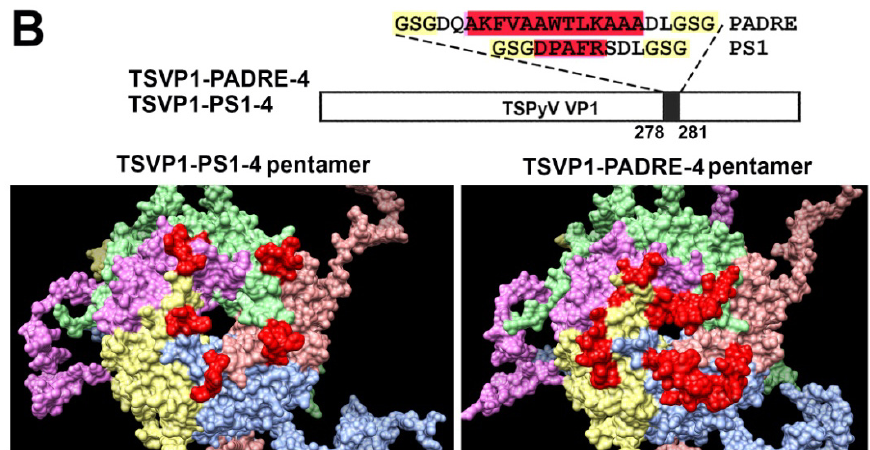
Figure 2. Molecular models of TSPyV VP1-derived chimeric proteins harboring either PS1 peptide (construct short name TSVP1-PS1) or PADRE peptide (construct short name TSVP1-PADRE) at site #1 (( A ) constructs TSVP1-PS1-1 and TSVP1-PADRE-1) or site #4 (( B ) constructs TSVP1-PS1-4 and TSVP1-PADRE-4). The inserts are shown in red.